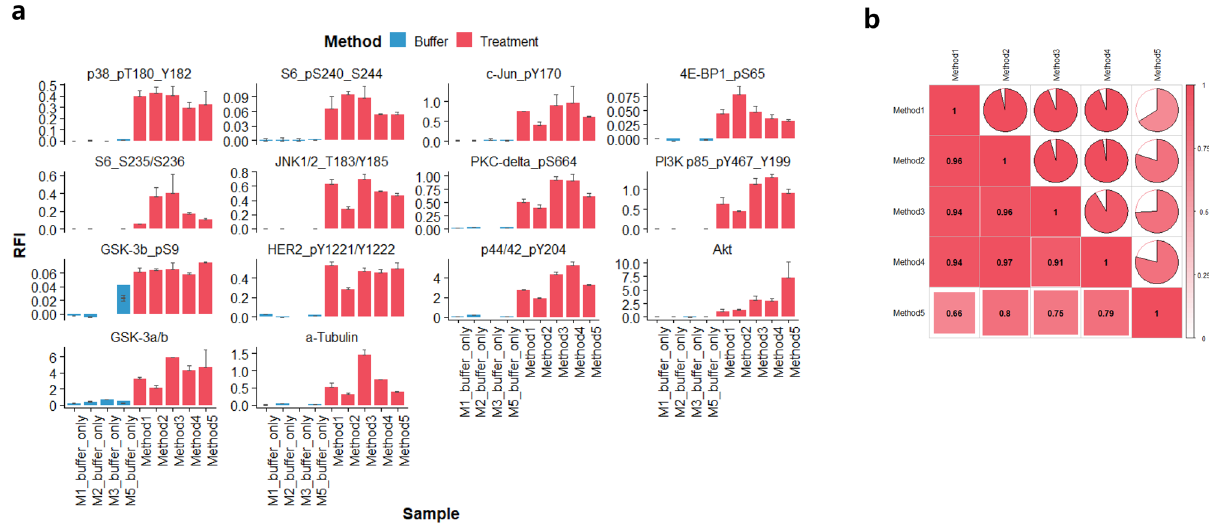
Figure 2. RPPA profiling of multiple targets using 4 extraction methods on FFPE samples. a. Expression profiling of 4 extraction methods (method 1–4) presented by arbitrary units (relative fluorescent intensity RFI) and error bars represent standard deviation from 3 independent extractions. Method 5 is under the same condition as Method 4 without alkaline phosphatase inhibitor. Blue bars are on-chip buffer only controls assessed within the same experiments. b. Inter-method correlation based on 14 protein markers and R 2 are shown from white to red